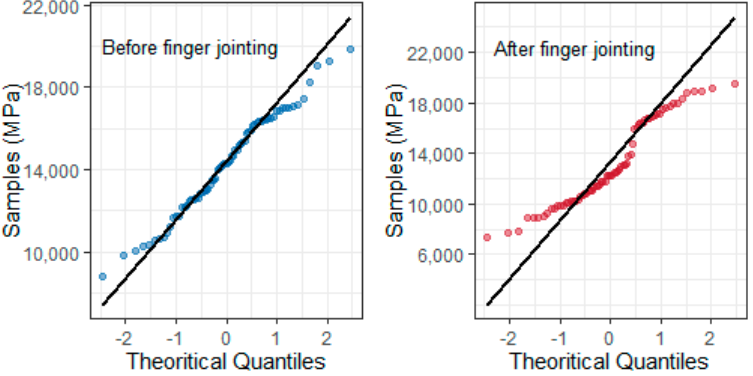
Figure 6. Quantile–quantile (Q-Q) plots of edgewise MoE data sets.